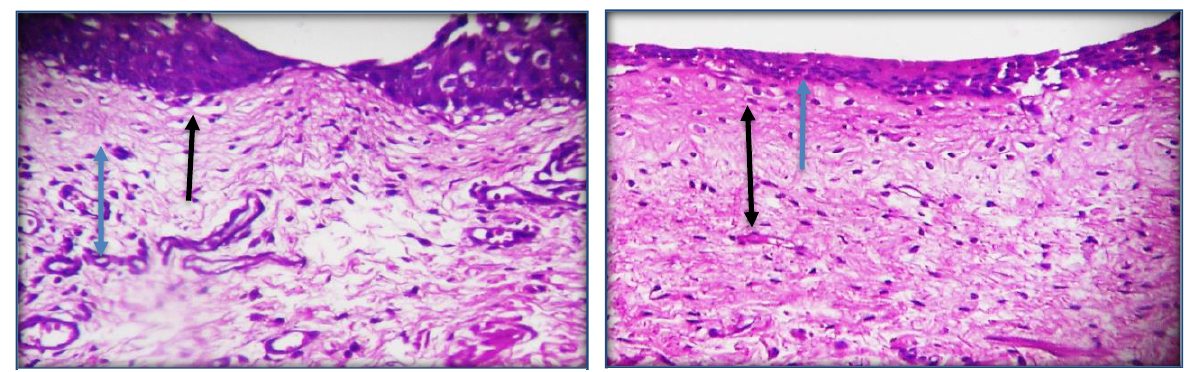
Figure, 13: Dog urinary bladder closed by appositional pattern, 21 days post-operation shows, the incisional site is filled with mature connective tissue consisting from regular dense collagen fibers with few fibroblasts and blood vessels (black arrow) covered by several layers of epithelial cells (blue arrow) (H&E.,